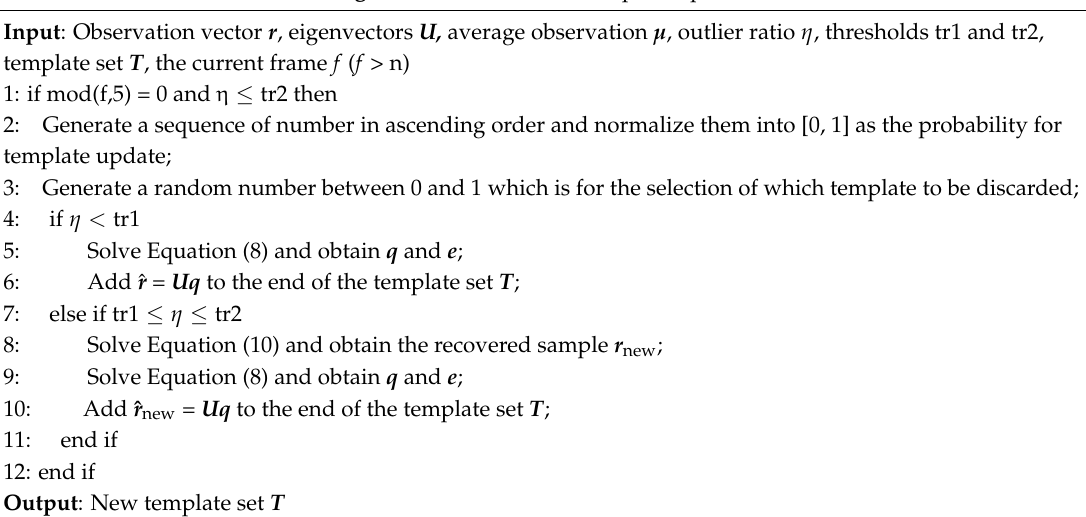
Algorithm 1. Method for template